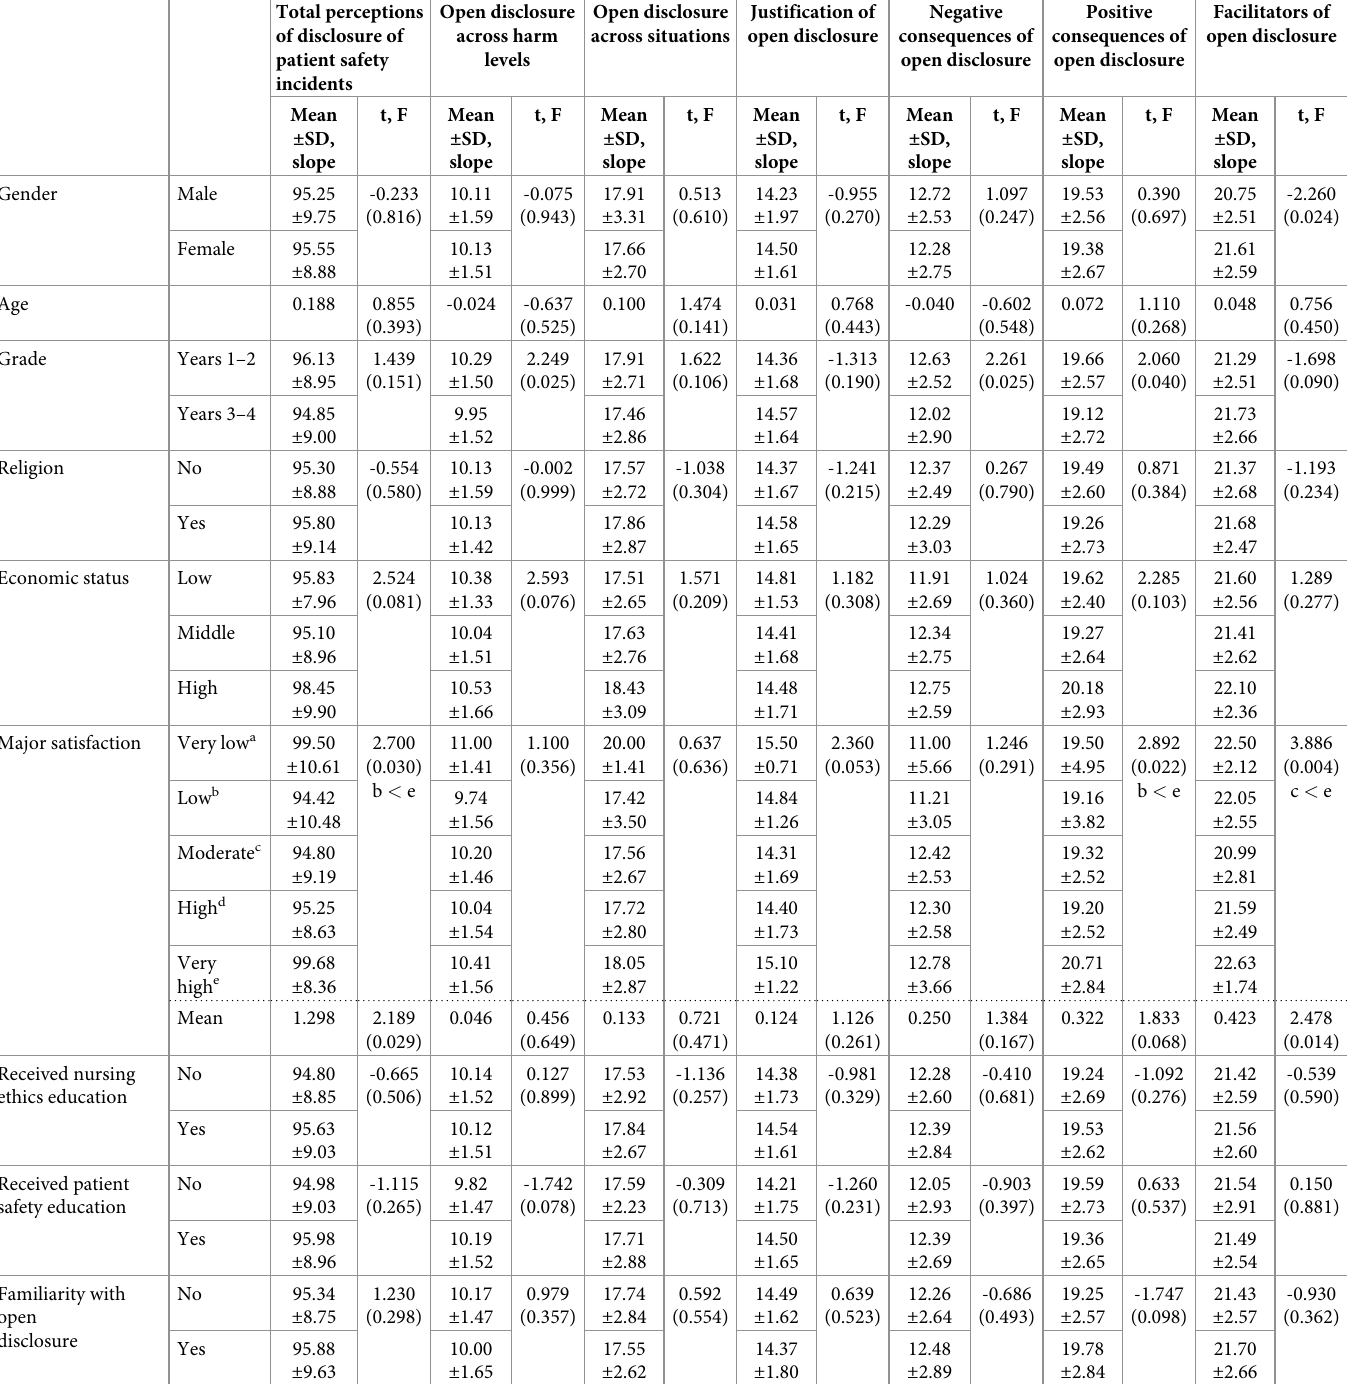
Table 3. Differences in perceptions of disclosure of patient safety incidents based on general